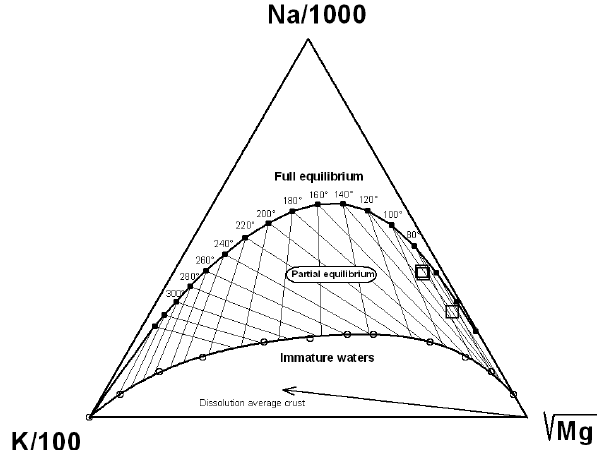
Fig. 9. Oxygen-18 vs. Deuterium plot showing Eastern Mediter- ranean Meteoric Water Line (EMMWL) of Gat and Carmi (1970), Local Meteoric Water Line and the field of local meteoric water (INGV Database, unpublished data). Water stable isotopes suggest waters are modified by diagenetic processes.